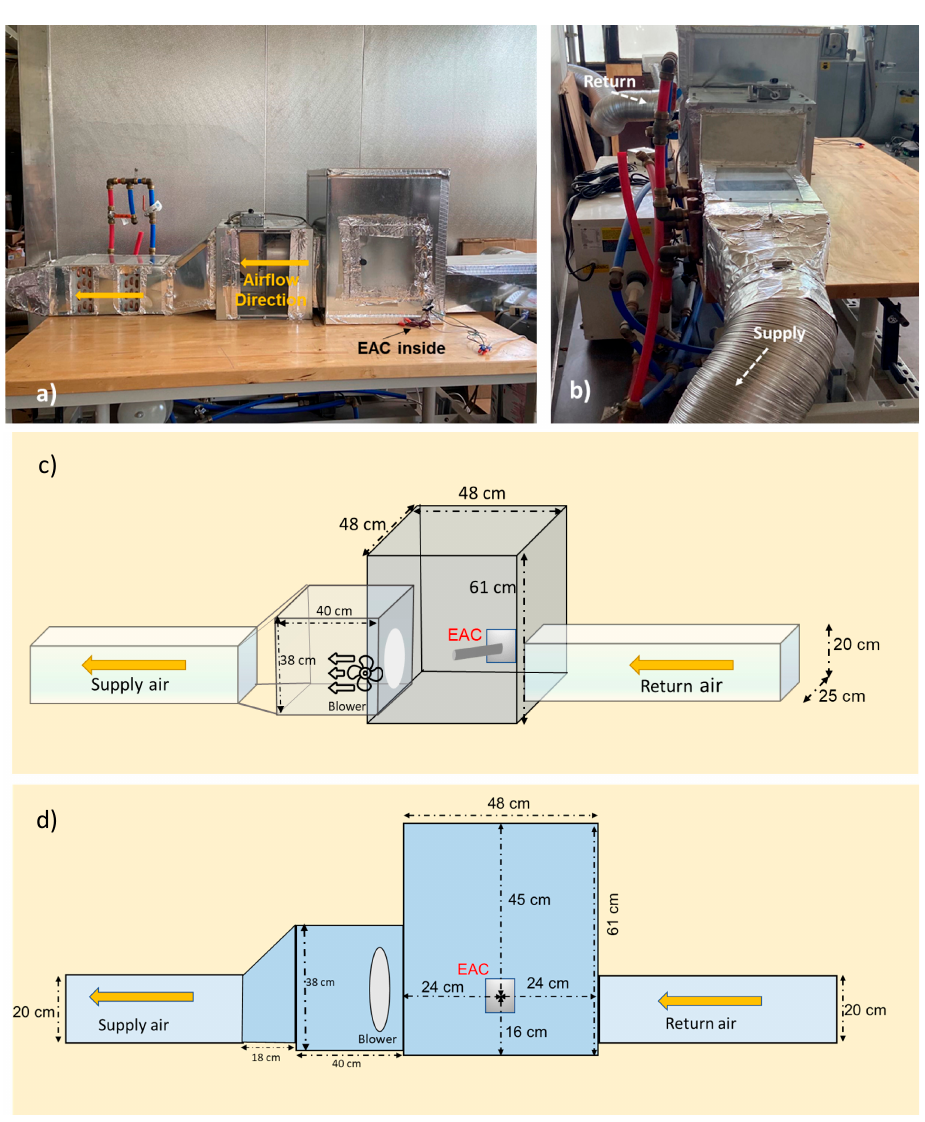
Figure 1. Photographs ( a , b ) and schematic drawings ( c , d ) of a custom air handling unit and ductwork serving the chamber in recirculation mode, with the ionizing/oxidizing electronic air cleaner (EAC) installed in a plenum, used for experimental in Chicago, IL, USA.